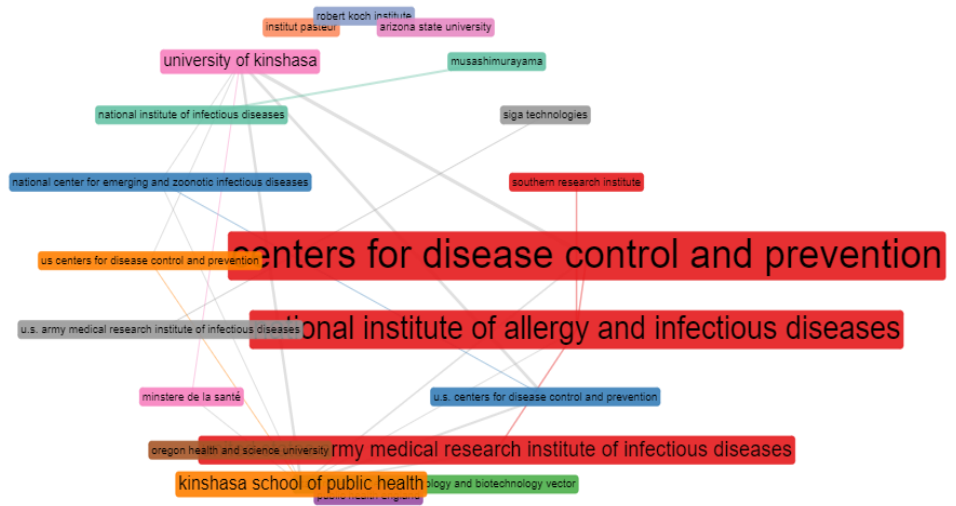
Figure 6. Visualization of institutions collaborations.